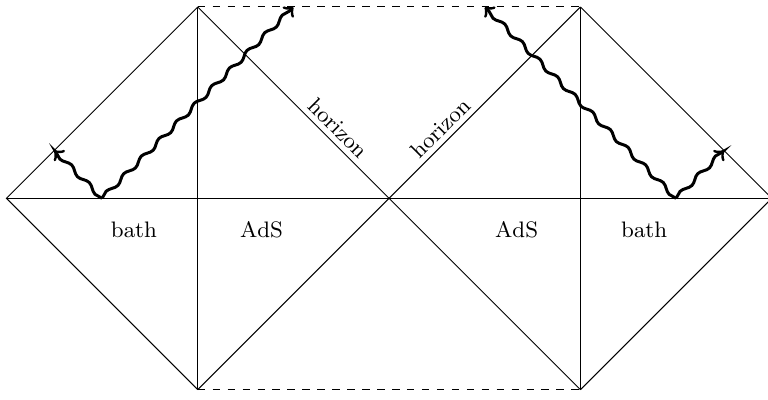
Figure 5 . The set-up consists of the two-sided black hole in thermal equilibrium with the left and right (cid:13)at space with the CFT acting as a thermal bath. Operator insertions in the baths create shockwaves that enter the AdS region and the black hole. The symmetry between the left and right is chosen to simplify the